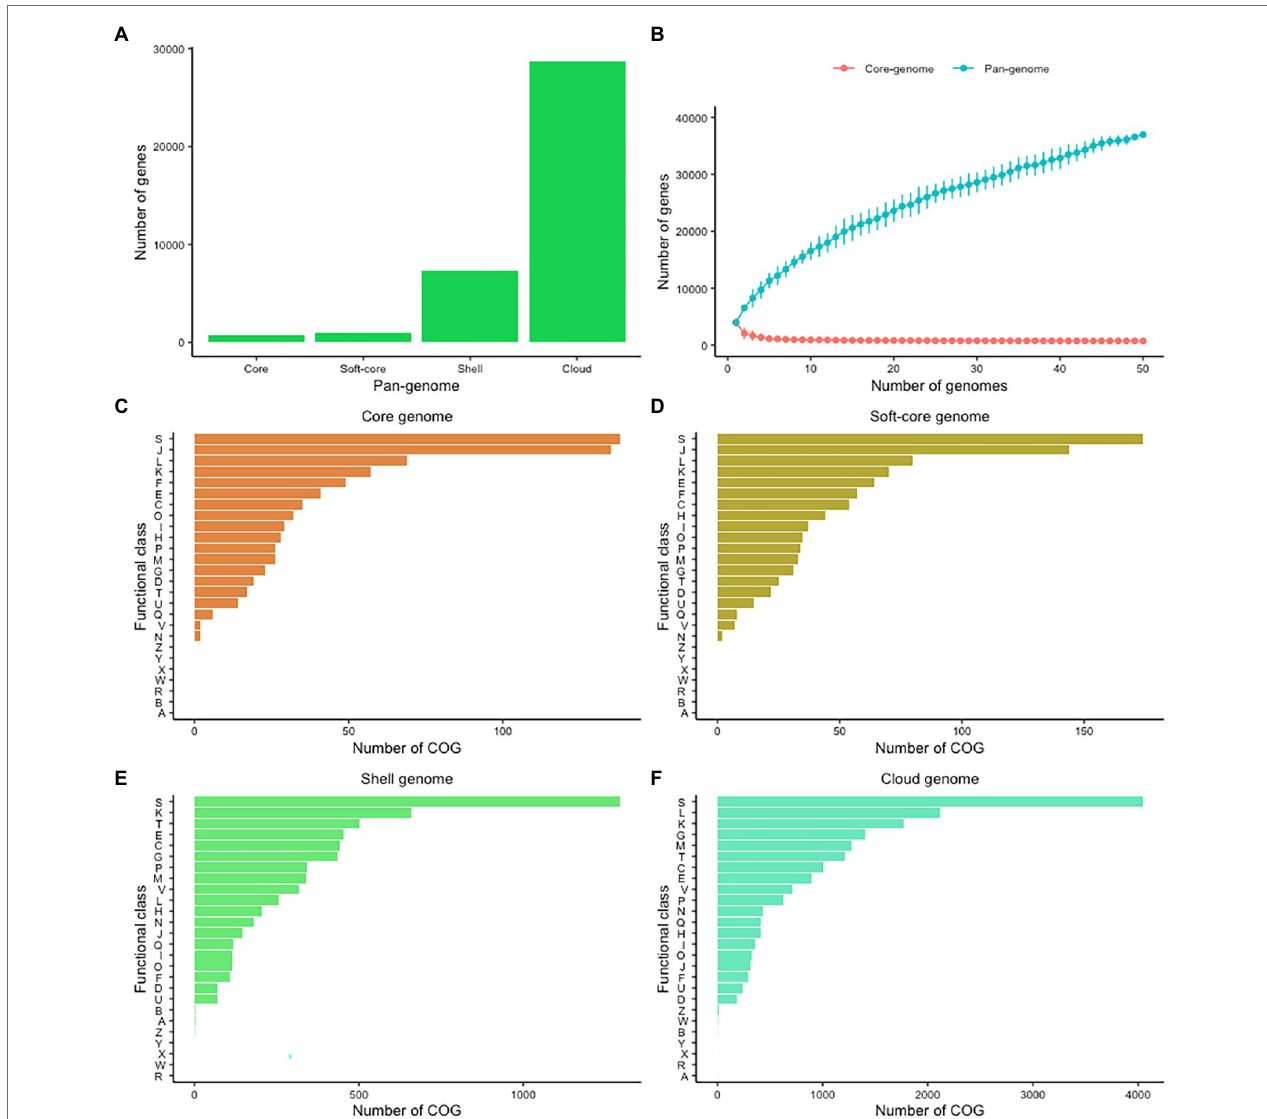
FIGURE 2 | The pan-genome of CEC. (A) The sizes of core-, soft-core, shell-, and cloud-genomes at 80% BLAST cutoff identity. (B) The sizes of core- and pan- genomes in relation to numbers of genomes added into the gene pool as a function of the number of genomes included. (C–F) Distribution of cluster of orthologous genes (COGs) in the core, soft-core, shell-, and cloud-genomes. COG categories: A, RNA processing and modification; C, energy production and conversion; D, cell cycle control and mitosis; E, amino acid metabolism and transport; F, nucleotide metabolism and transport; G, carbohydrate metabolism and transport; H, coenzyme metabolism; I, lipid metabolism; J, translation; K, transcription; L, replication and repair; M, cell wall/membrane/envelop biogenesis; N, cell motility; O, post-translational modification, protein turnover, chaperone functions; P, inorganic ion transport and metabolism; Q, secondary structure; R, general functional prediction only; S, function unknown; T, signal transduction; U, intracellular, trafficking and secretion; V, defense mechanisms; W, extracellular structures; X, mobilome: prophages, transposons; and Z,